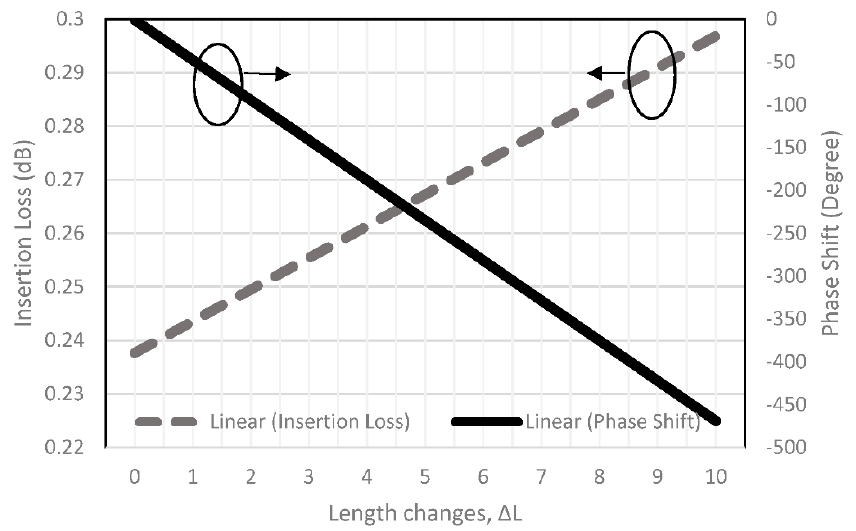
Figure 6. Insertion loss and phase shift of the strip line length changes, Δ L.